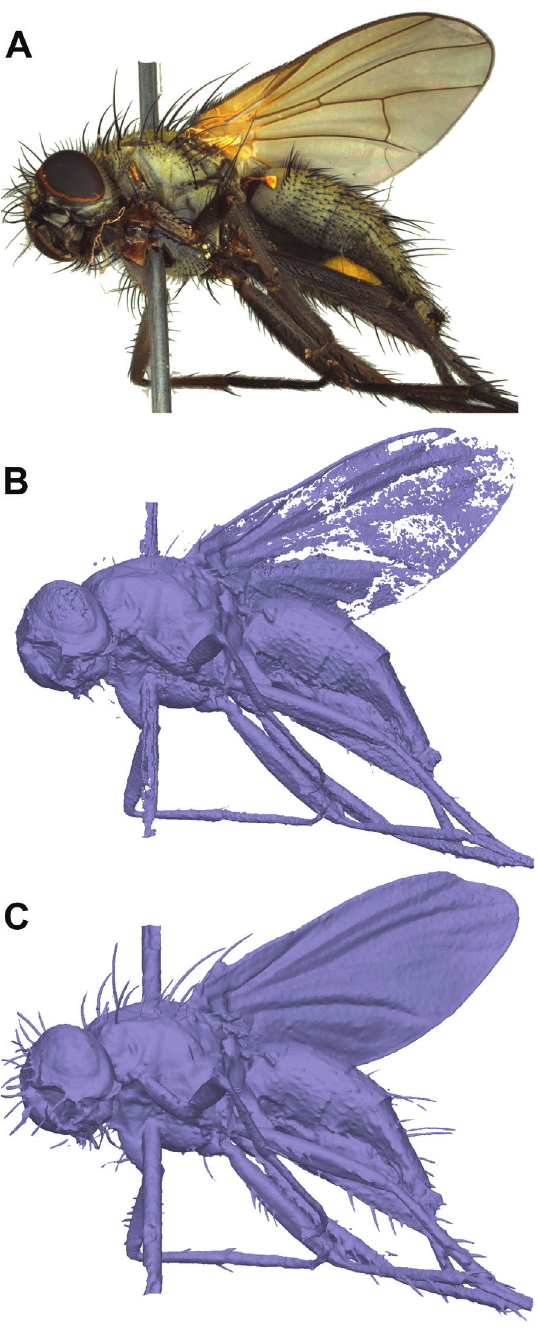
Figure 10. Comparison of dense-cloud-based mesh generation and visual consistency meshing of Thricops sp. ( A EDOF image). Thin and delicate structure like wings and setae are not well modelled from the dense cloud ( B ) but well preserved by visual consistency meshing ( C